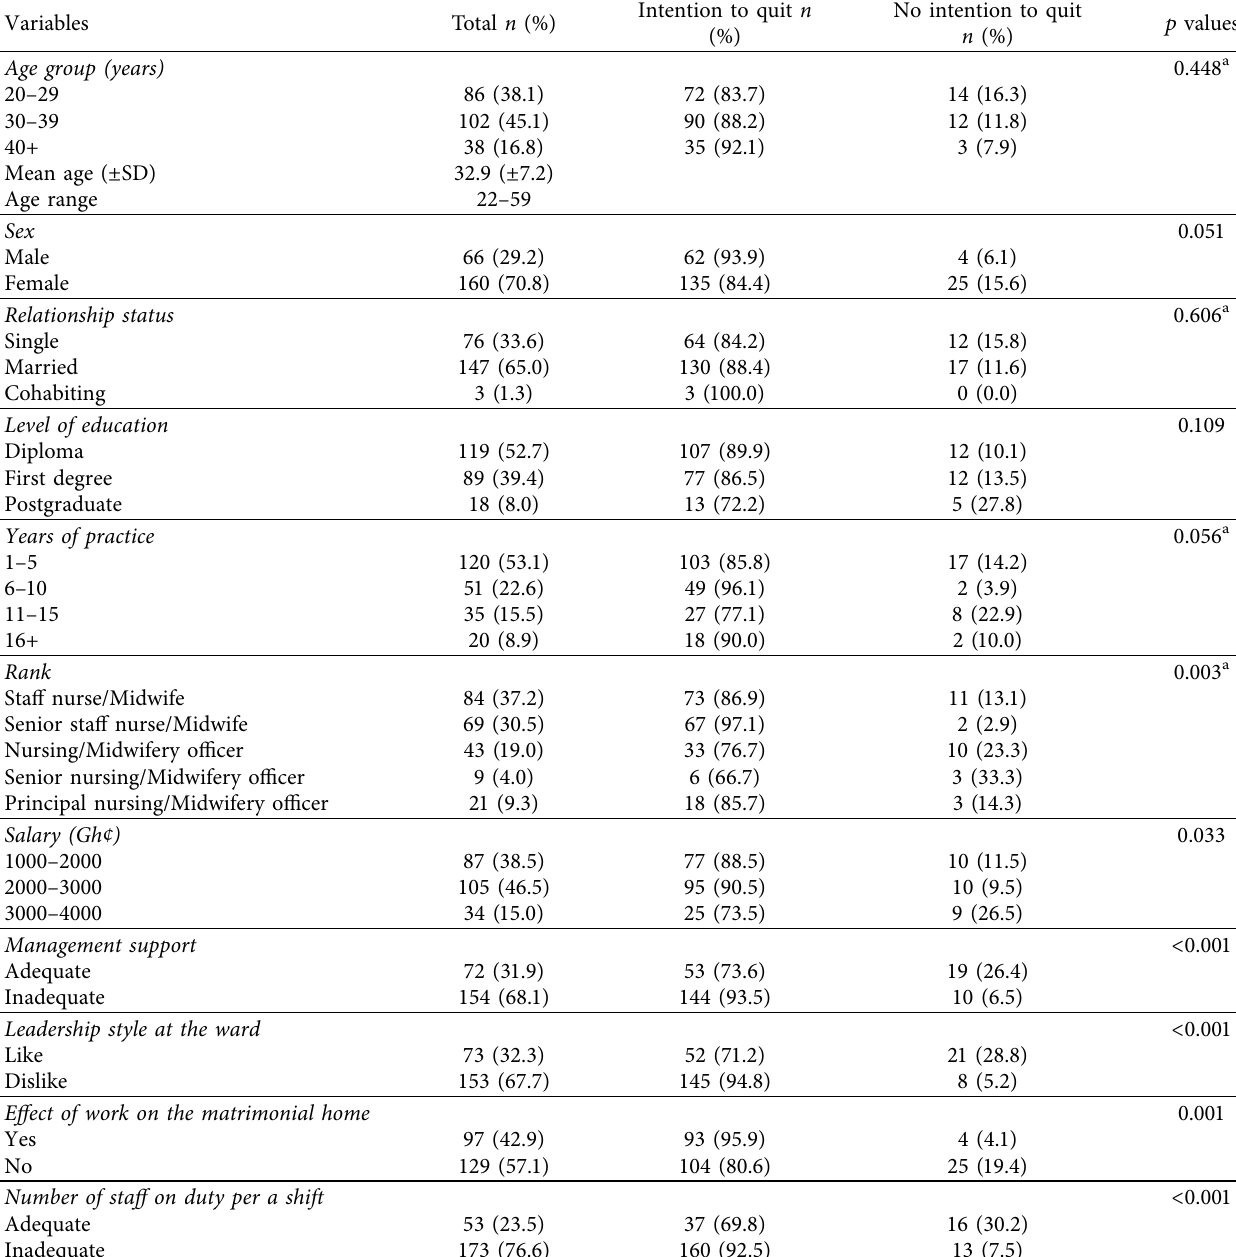
Table 1: Demographic characteristics and workplace environment of study